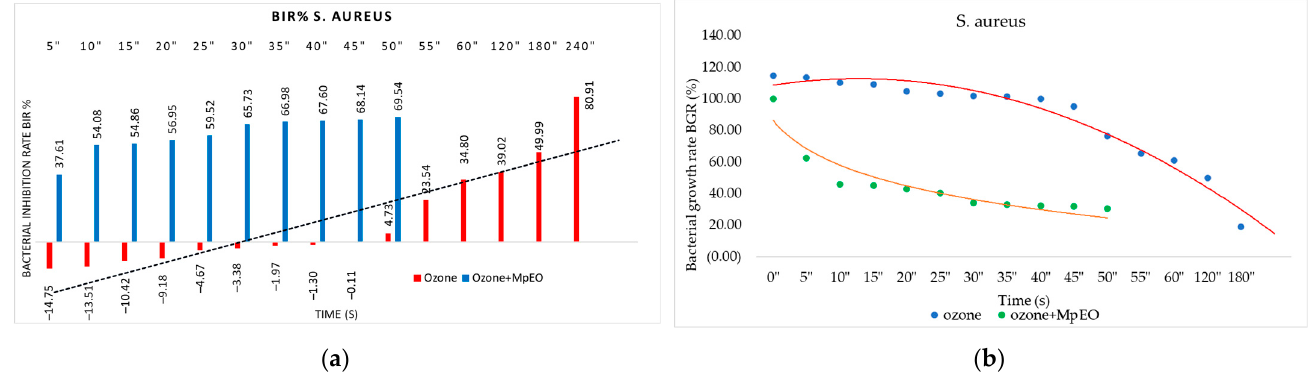
Figure 3. Ozone and ozone+MpEO antimicrobial activity on S. aureus at different time exposures expressed in seconds ( ″ ). ( a ) Results expressed as BIR%; ( b ) results expressed as BGR%.